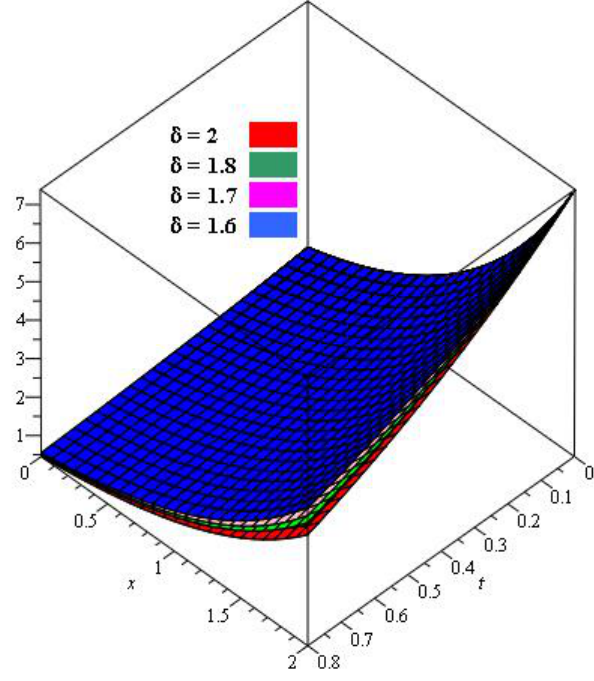
Figure 3. NTDM solution of Example 2 at different fractional-order δ =